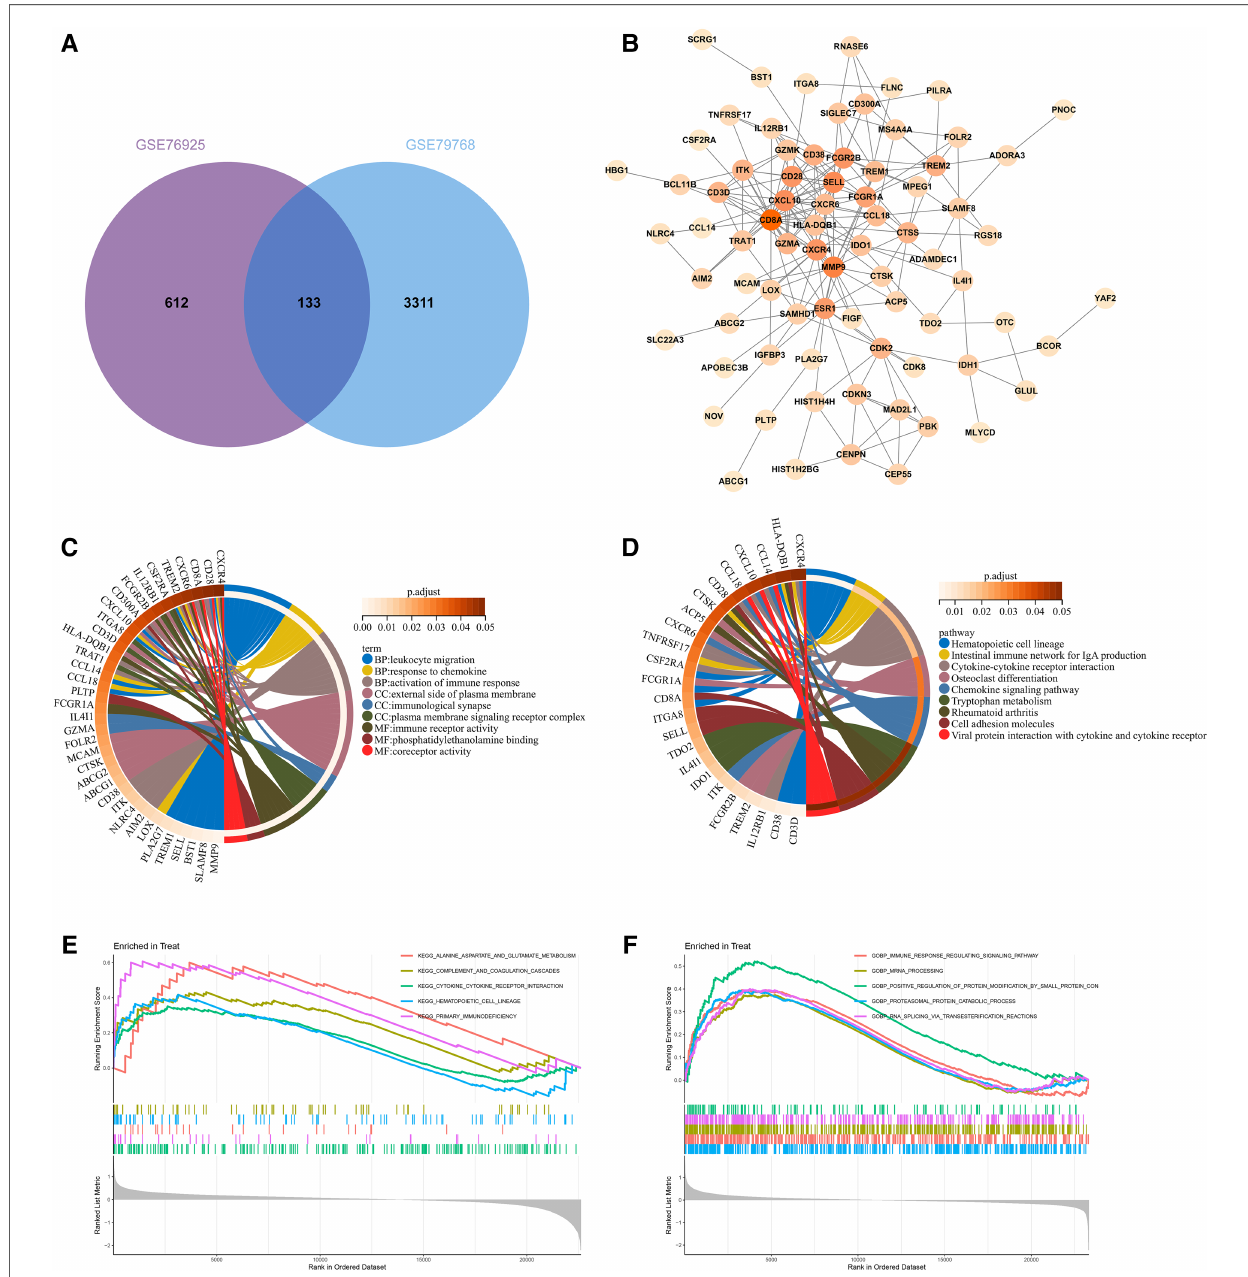
FIGURE 3 Construction of overlapping gene PPI networks and enrichment analysis. ( A ) Venn diagram of COPD and AF module genes. ( B )PPI network. ( C ) KEGG pathway analysis of genes. Different colors represent various signi fi cant pathways and related enriched genes. ( D ) GO analysis of genes. Different colors represent various signi fi cant pathways and related enriched genes. ( E ) GSEA enrichment analysis of upregulated genes in the COPD dataset. ( F ) GSEA enrichment analysis of upregulated genes in the AF